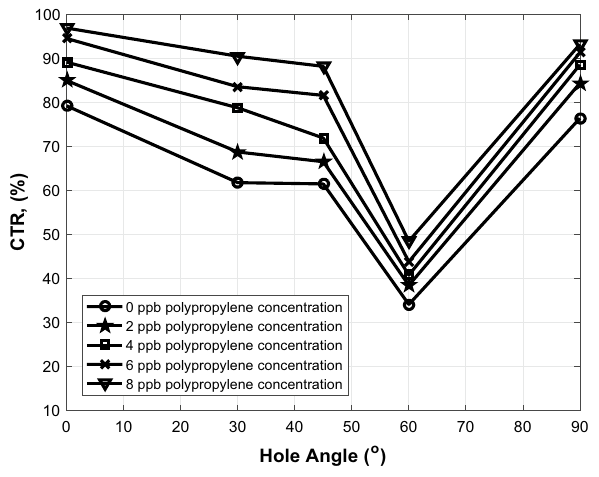
Fig. 4 Cutting transport ratio vs. hole angle for cuttings size of 2.0–